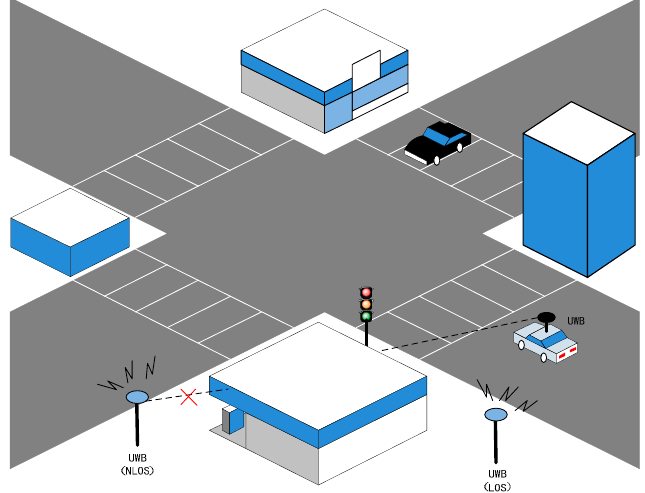
Figure 3. Typical NLOS situation in intersection scenarios.